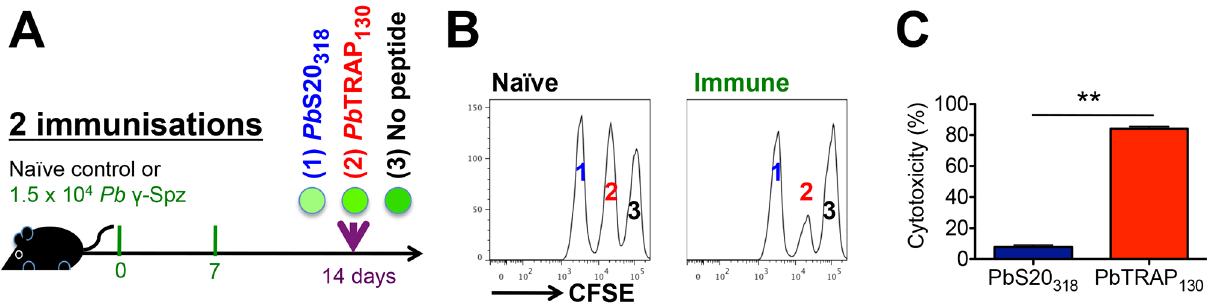
Figure 4. Pb TRAP 130 -specific CD8 + T cell responses are cytolytic invivo . ( A ) Schematic diagram of methodology. Target cells were prepared by pulsing syngeneic spleen cells with Pb S20 318 , Pb TRAP 130 , or no peptides prior to labelling with CFSE. Target cells were transferred into naı¨ve or immunised mice 14 days from last Pb c -Spz immunisation. Spleens of recipient mice were harvested 24 hours later and analysed for CFSE fluorescence. ( B ) Representative histogram plots showing the fates of transferred cells in naı¨ve (left) or immune (right) mice. The disappearance of a fluorescent peak signifies cytolysis of labelled splenocytes. ( C ) Quantification of in vivo cytolytic activity (**p , 0.01, Mann-Whitney test). Figures are representative data from one of 3 experiments with 4 mice/group/experiment.